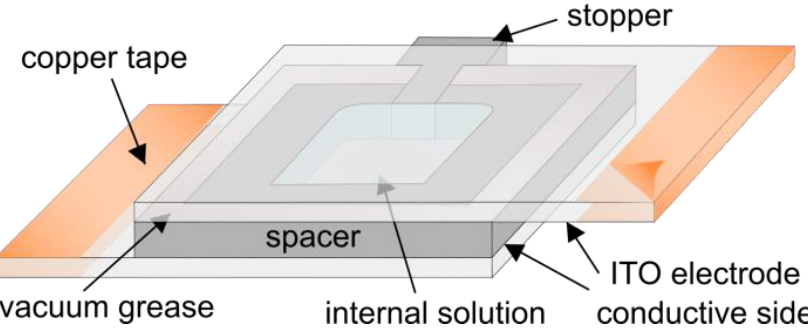
Figure 5. Schematic drawing of a chamber used in electroformation experiments.